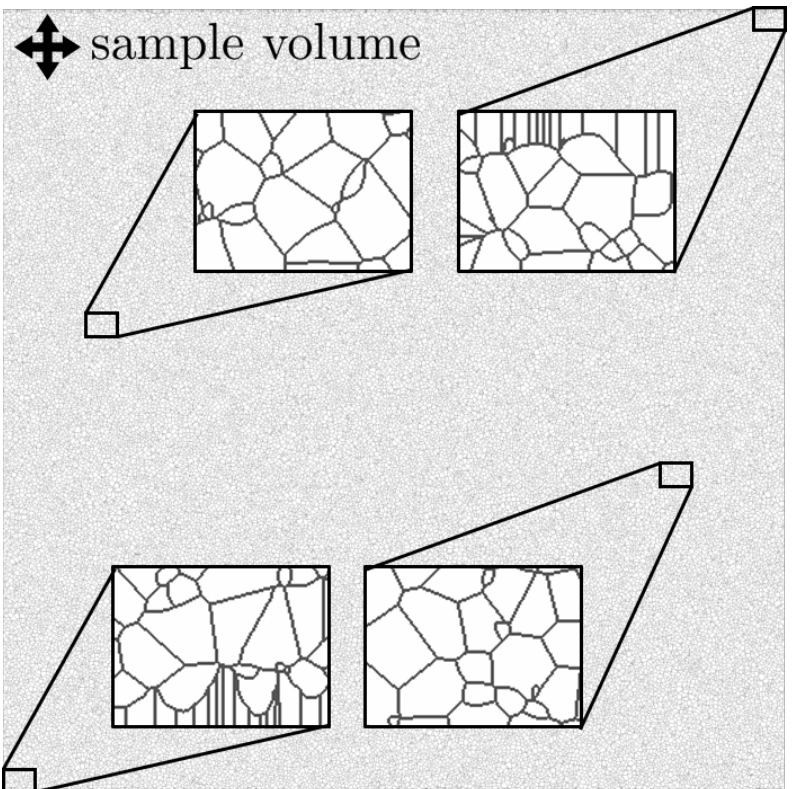
Figure 7. Depicted is the spherulite structure of a sample volume with four detail views. The edge structure as well as the approximately homogeneous spherulite size in the center of the simulation area can be seen.